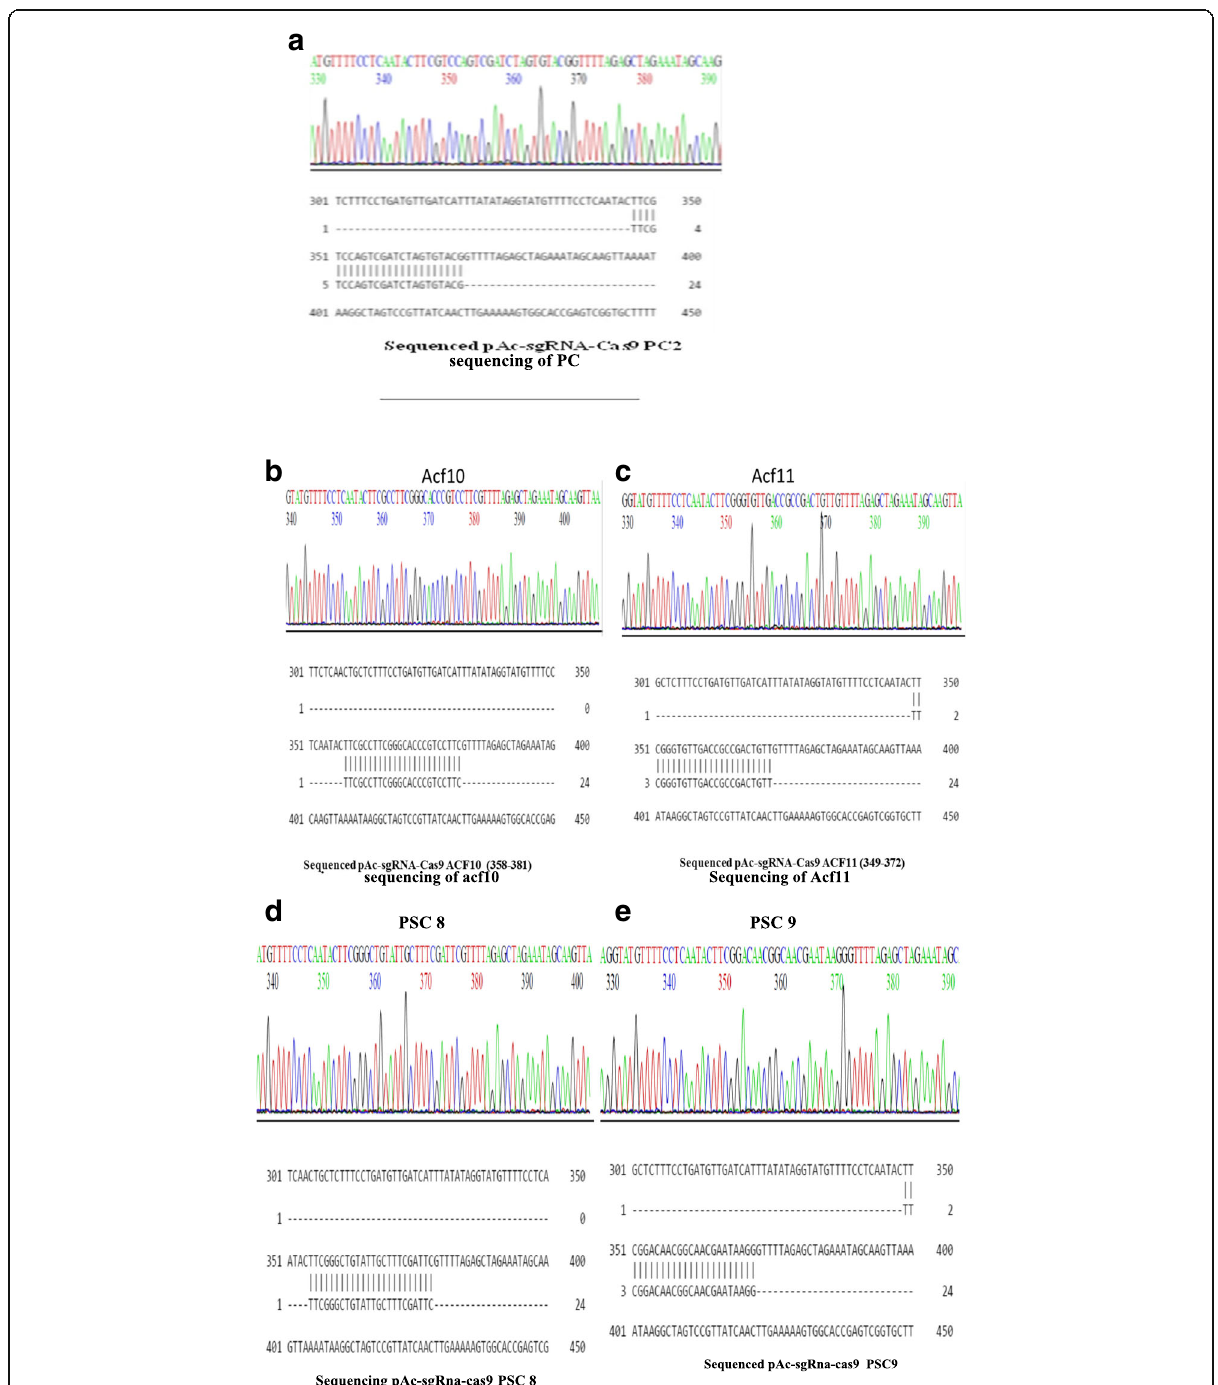
Fig. 9 a Sequencing of PC. b sequencing of acf10. c Sequencing of Acf11. d Sequencing pAc-sgRna-cas9 PSC 8. e